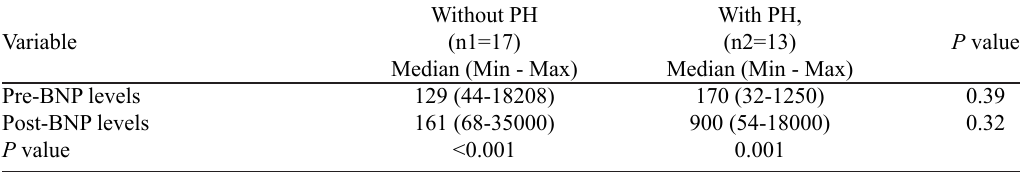
Table 4. BNP levels before and after